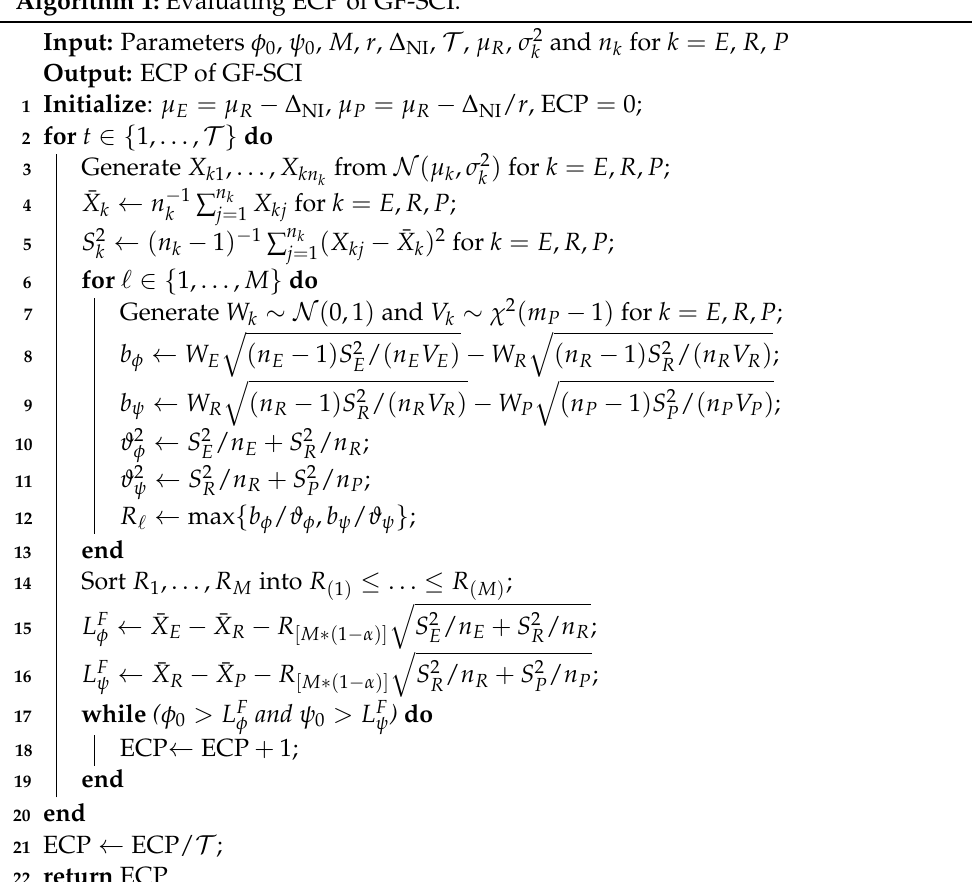
Algorithm 1: Evaluating ECP of